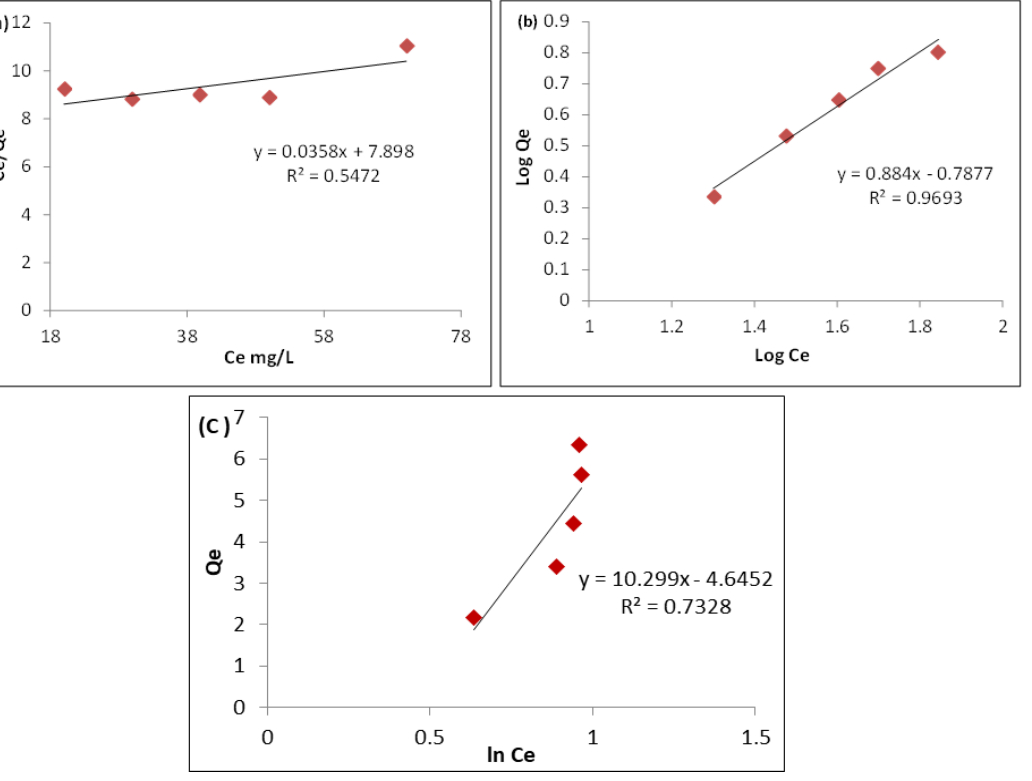
Figure 6. Adsorption isotherms (Langmuir model ( a ) Freundlich model ( b ) and Temkin model ( c )) for removal of MB dye using Zeo-FPT. Table 4. Adsorption isotherm parameters calculated for the removal of MB using Zeo-FPT .